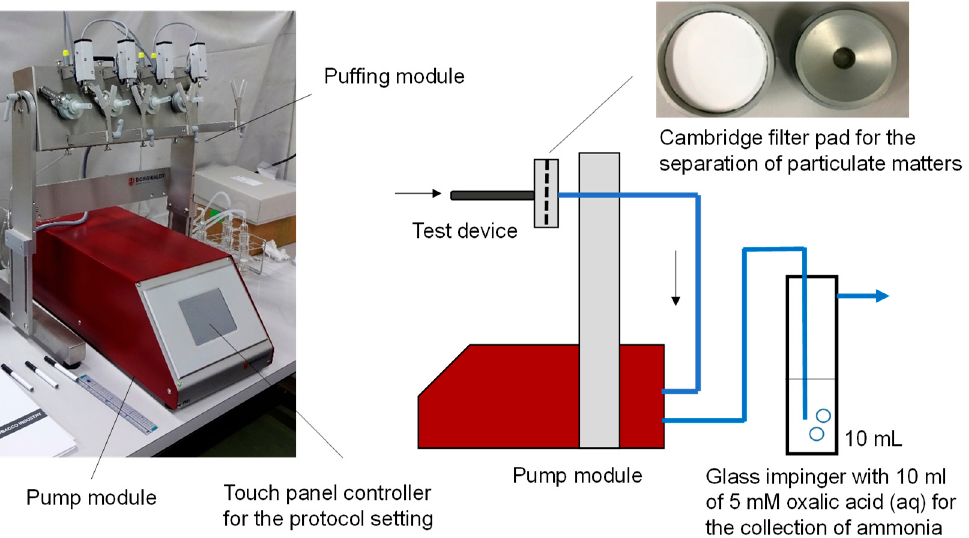
Figure 1. Schematic view of the vaping machine and sampling apparatus used in this study.